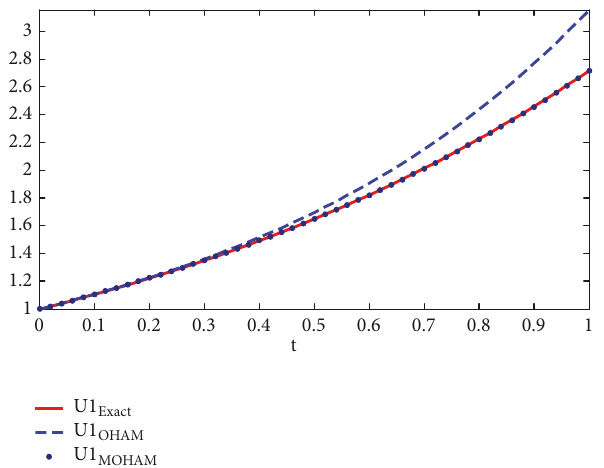
Figure 1: The results of OHAM, MOHAM, and exactsolution for u1 in Example 1.